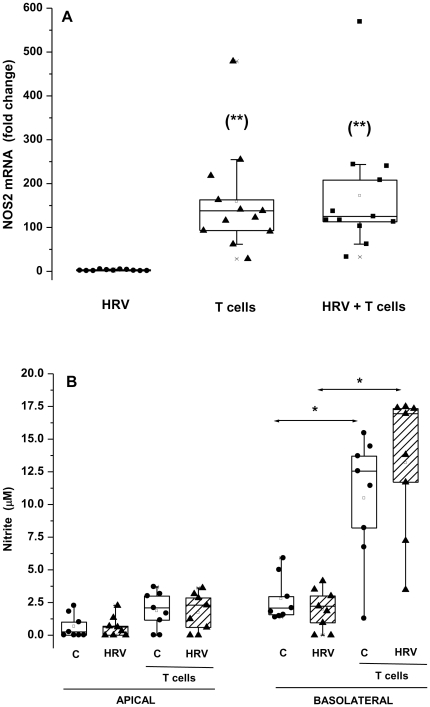
Epithelial NOS2 mRNA expression and NO release are induced by T cells but not HRV14.HNEC were either not infected (C) or exposed apically to HRV14 alone (HRV), or co-cultured with activated T cells alone (T cells), or exposed to HRV14 washed thoroughly then co-cultured with activated T cells (HRV+T cells). (A) mRNA was determined by real-time PCR and data represented as fold increase relative to non-infected cells cultured without T cells. (B) NO secretion is expressed as the amount of nitrite (the stable oxidation product of NO) released in the apical and basolateral compartments (µM). Shown are the boxplots with the 25th, 50th (median), 75th percentiles, the mean (open square), the maximum and the minimum values. *p<0.05. **p<0.05 compared with HRV-infected cells.